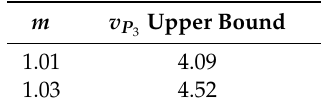
Table 6. Calculated displacement upper bound.